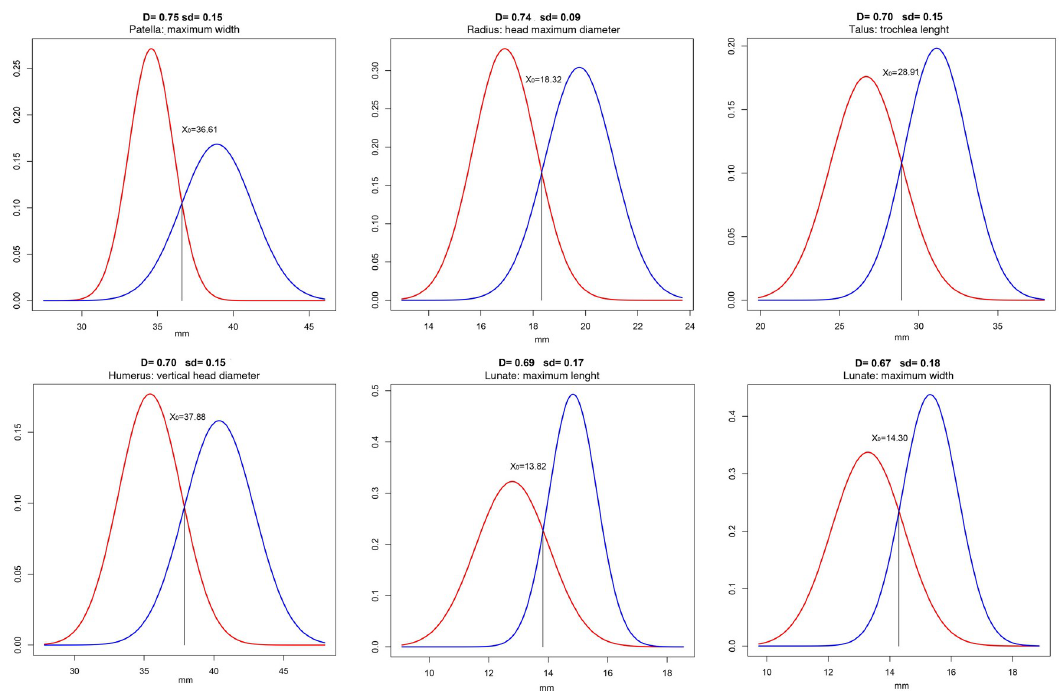
Fig 5. The most dimorphic traits. Normal distribution curves derived from the sample female (red line) and male (blue line) means, standard deviations and N. D = Chakraborty and Majumder’s D-value; sd = standard deviation; X0 = cut-off point.